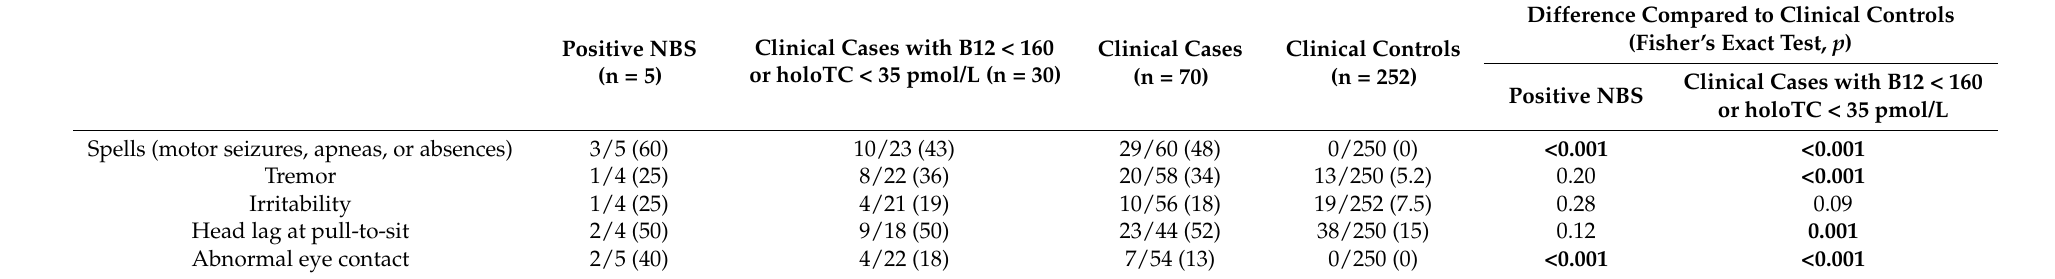
Table 3. Clinical symptoms and findings of cases and controls, n